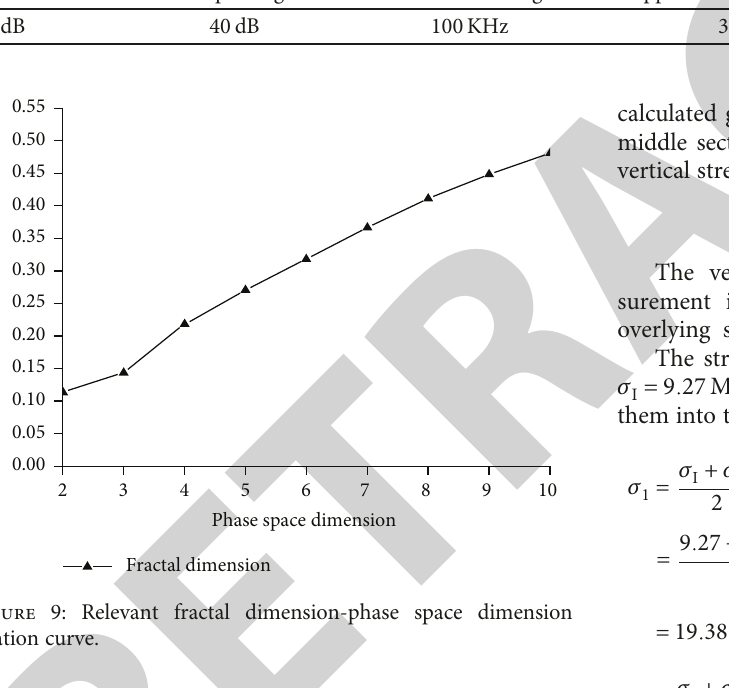
Figure 9: Relevant fractal dimension-phase space dimension relation